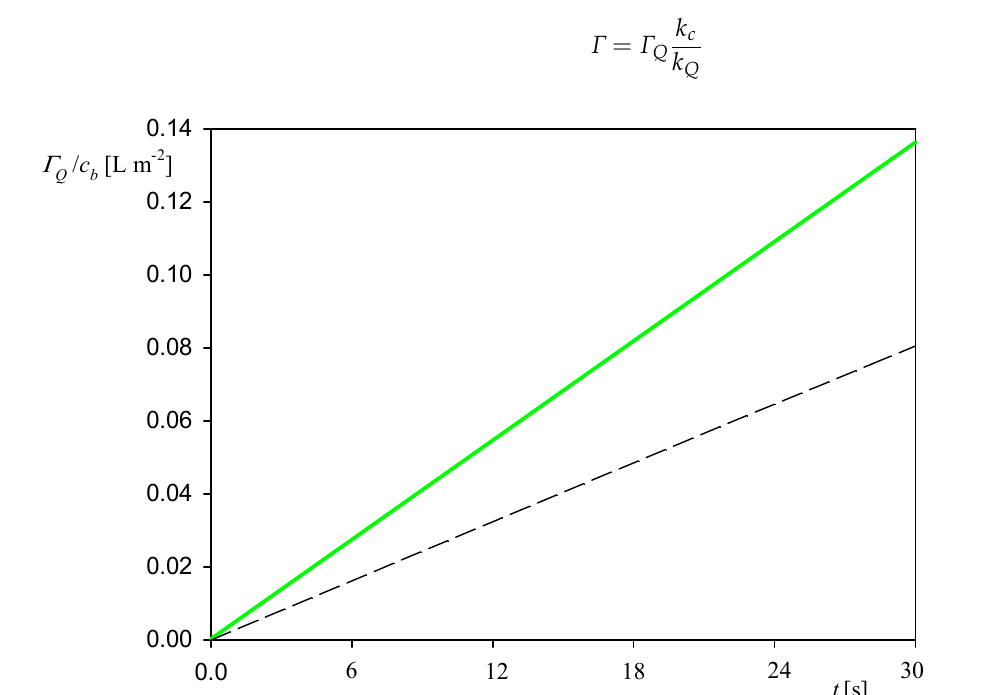
Figure 3. Dependence of the normalized myoglobin coverage Γ Q / c b on the adsorption time t. Results are averaged from five independent runs performed at different bulk suspension concentrations (5 and 10 mg L − 1 ); 0.01 M NaCl, flow rate of 2.5 × 10 − 3 cm 3 s − 1 , pH 3.5 and 4. The dashed line shows the dry mass calculated from Equation (3).